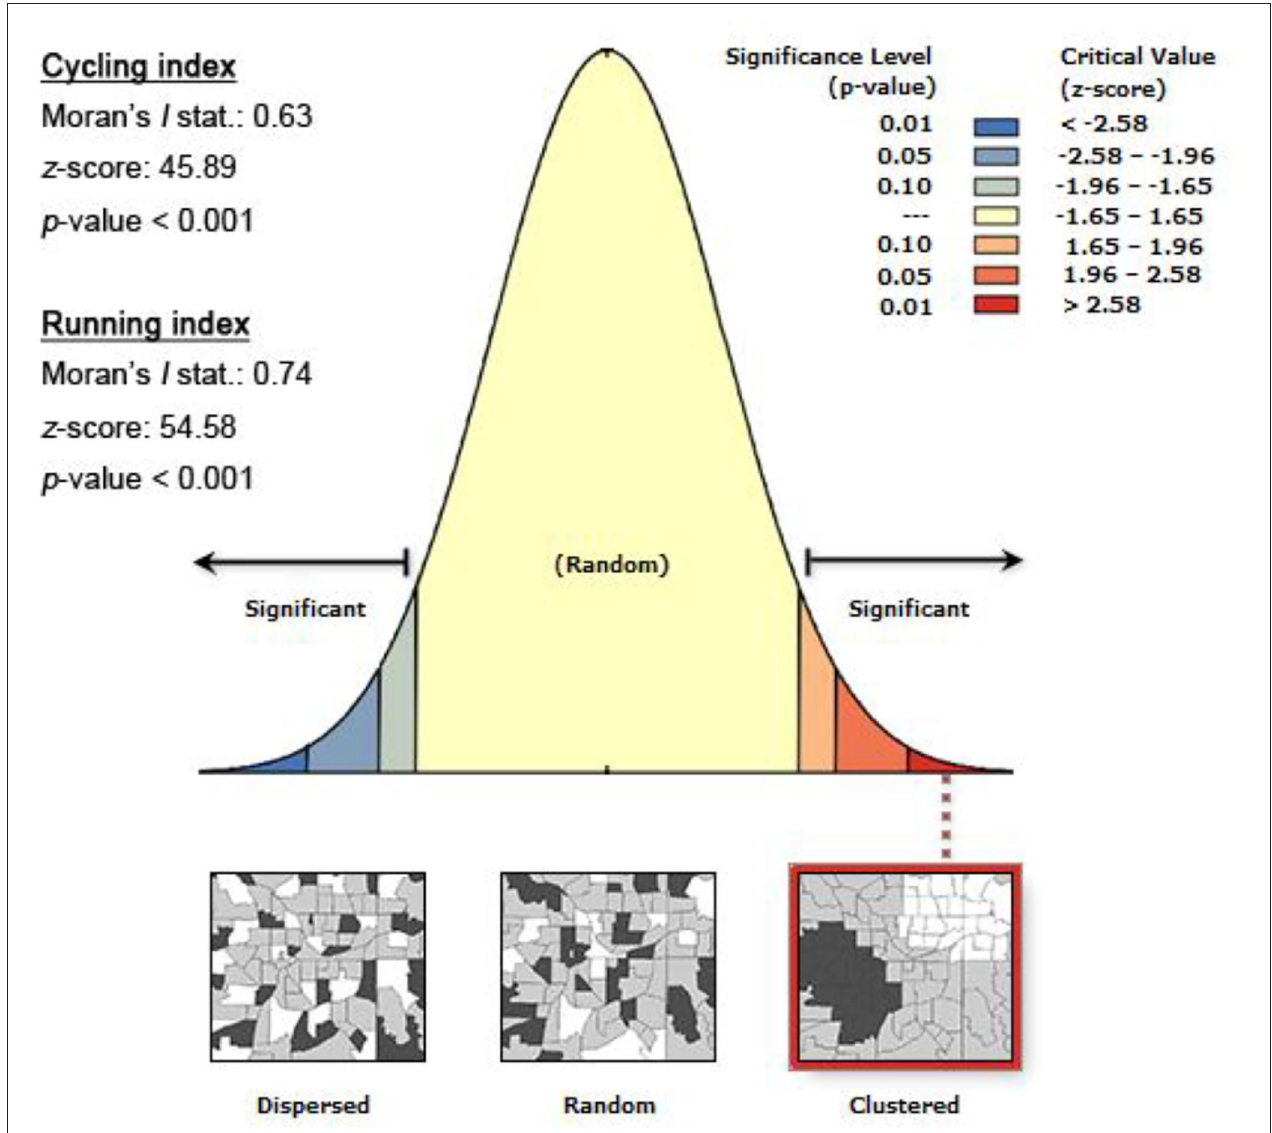
FIGURE 4 | Moran’s I statistics for the cycling and running